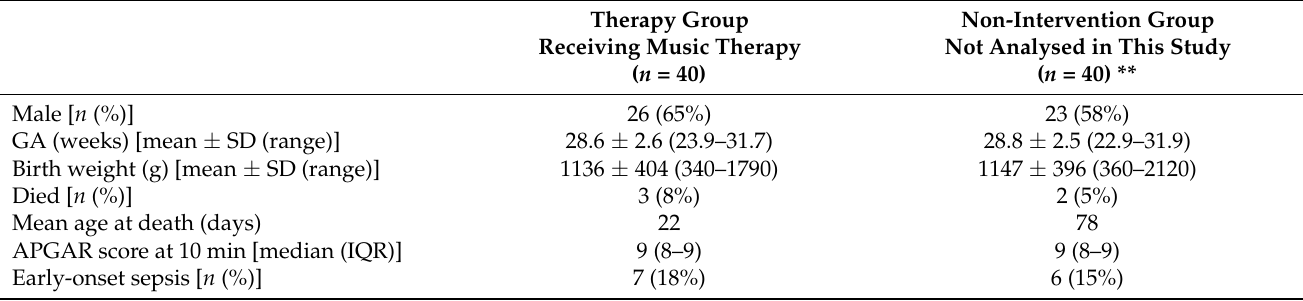
Table 1. Clinical characteristics of